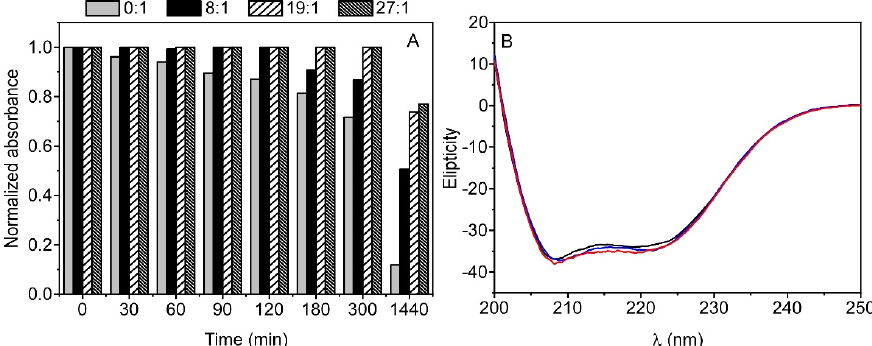
Figure 6. ( A ) Bar diagrams showing the normalized maximum absorption of TMZ (26 μ M) in phosphate buffer pH 7.4 at 25°C as a function of time, in absence (gray) and in presence of increasing HSA:TMZ molar ratios; 8:1 (black), 19:1 (striped) and 27:1 (densely striped). ( B ) Effect of TMZ on the molar ratios; 8:1 (black), 19:1 (striped) and 27:1 (densely striped). ( B ) E ff ect of TMZ on the CD spectrum CD spectrum of HSA (3.0 μ M). TMZ concentrations were: 0 (black), 20 (blue) and 200 μ M (red). of HSA (3.0 µ M). TMZ concentrations were: 0 (black), 20 (blue) and 200 µ M